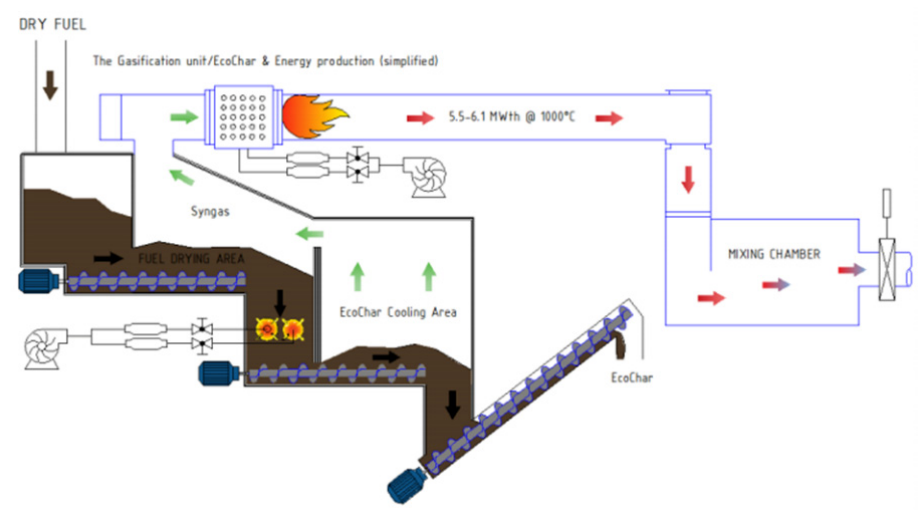
Figure 2. Technological scheme for obtaining organic material at the poultry farm “ROSKAR”, Leningrad Oblast.